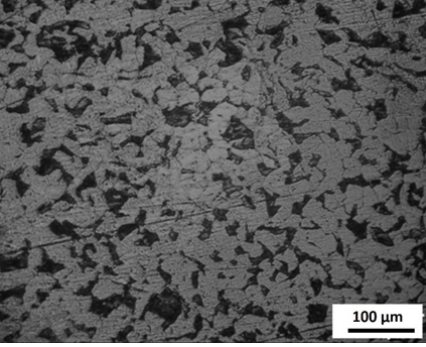
Figure 6: Microstructural